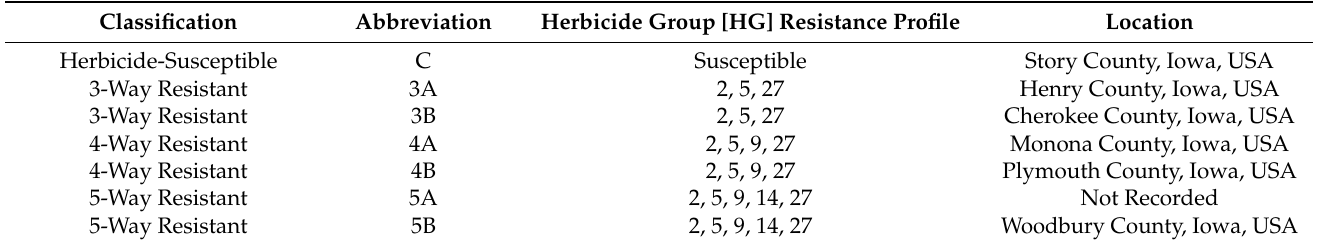
Table 1. Descriptions of multiple herbicide-resistant waterhemp populations collected in 2011 and used in the germination chamber very long chain fatty acid-inhibiting herbicide dose–response experiment.